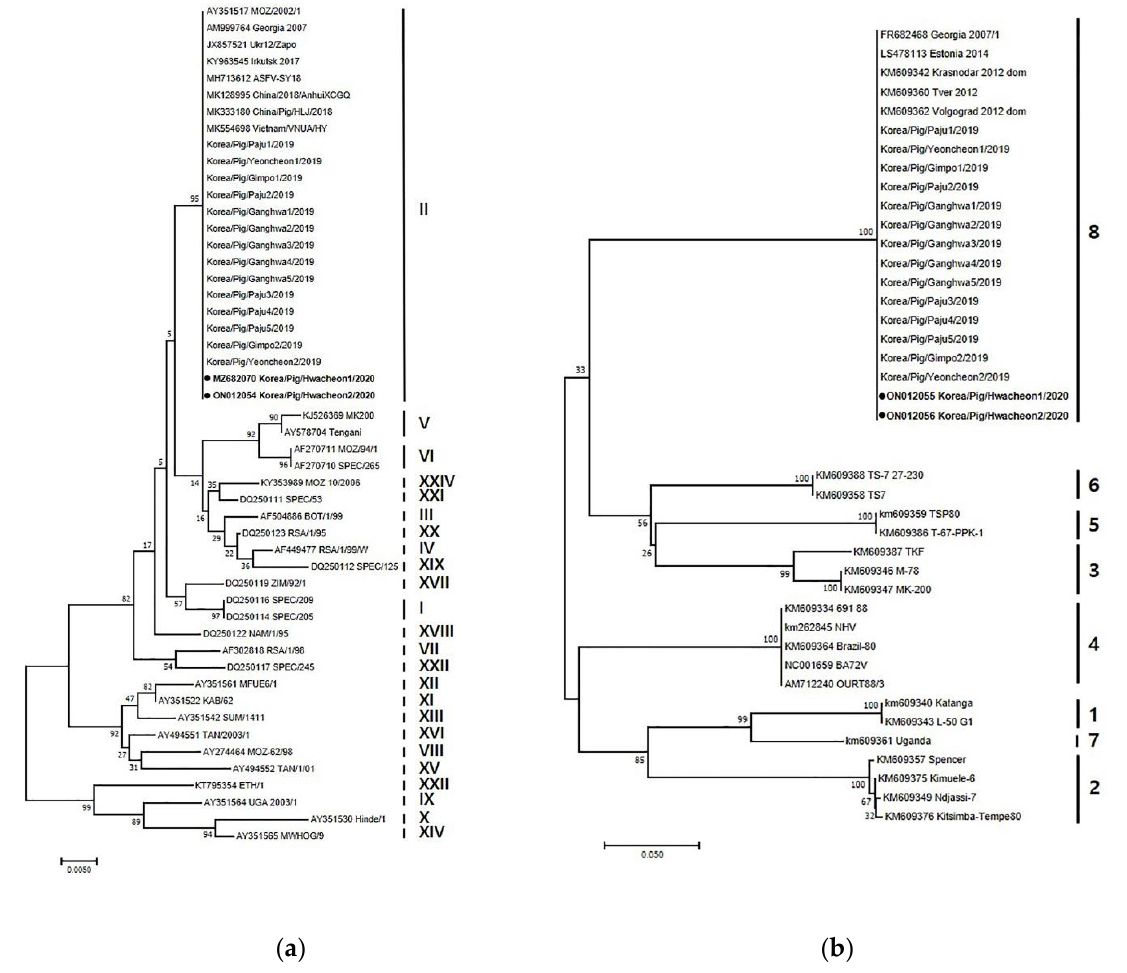
Figure 2. Phylogenetic analysis of ASFV isolated in domestic pig farms in South Korea during 2019-2020, based on partial sequence of the p72 gene (accession numbers MZ682070 and ON012054) and EP402R gene (accession numbers ON012055 and ON012056). ( a ) p72 genotype. ( b ) CD2v serogroup. The neighbor–joining method and Kimura 2-parameter model were used for constructing both phylogenetic trees in MEGA X software (https://www.megasoftware.net/). The two black dots indicate the ASFVs isolated in Korea in